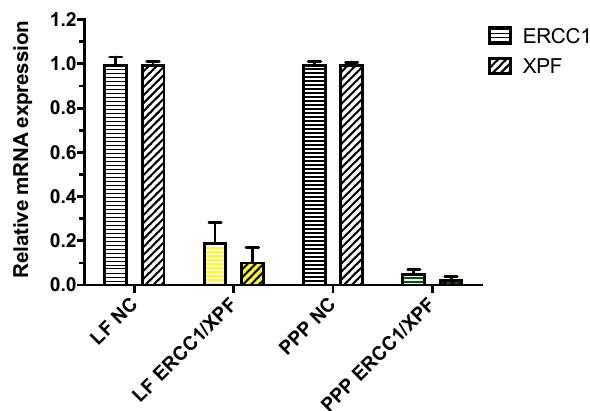
Figure 2. ERCC1 and XPF gene knockdown efficiency was validated in lung adenocarcinoma cells (A549) after 72 h following double transfection of Lipofectamine 2000 (LF) or micelleplexes (PPP) with 100 pmol ERCC1-XPF siRNA or negative control (NC) siRNA. ERCC1 and XPF expression was normalized with GAPDH expression and quantified by real time PCR. Data points indicate mean ± SD. (n = 6).